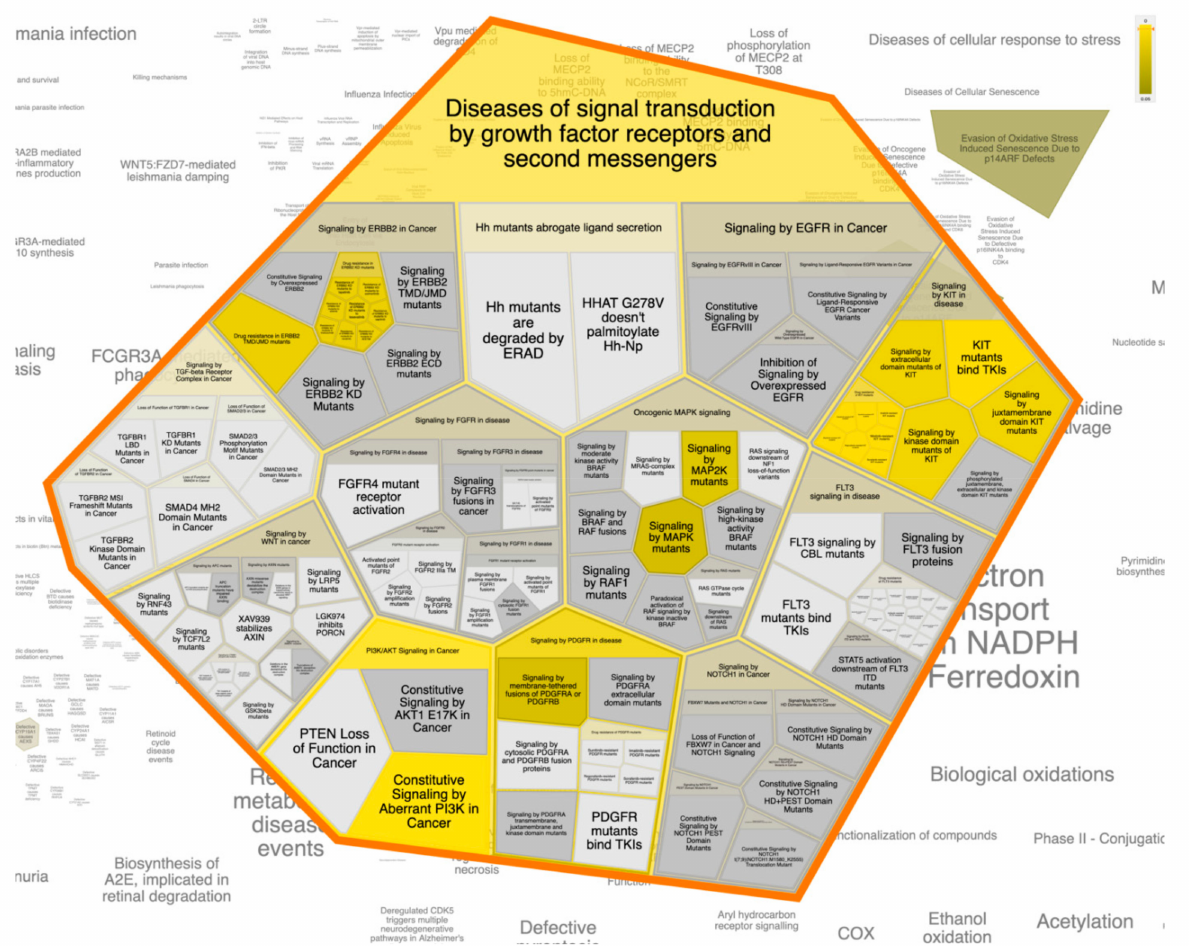
Figure 7. The Voronoi treemap of the top pathway (diseases of signal transduction by growth factor receptors and second messengers) influenced by the top 20 gene targets in response to ST-1